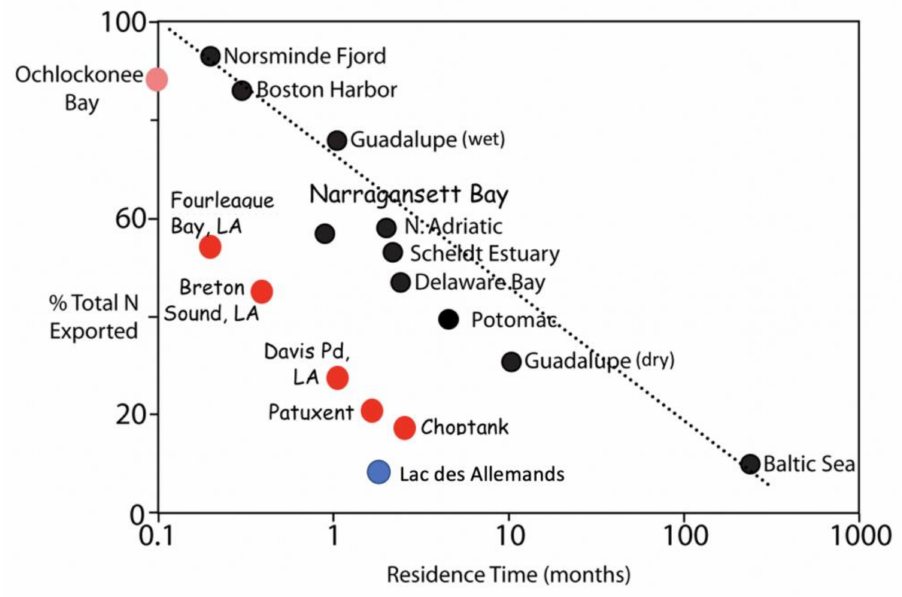
Figure 13. Percent of total N inputs that are exported from different estuarine systems versus freshwater residence time. The black circles are from [99] and [100]. Red circles are from more recent analyses by [103–105] and unpublished data (see [106]). Modified from [107]. Residence time of Lac des Allemands is approximately 2.6 months